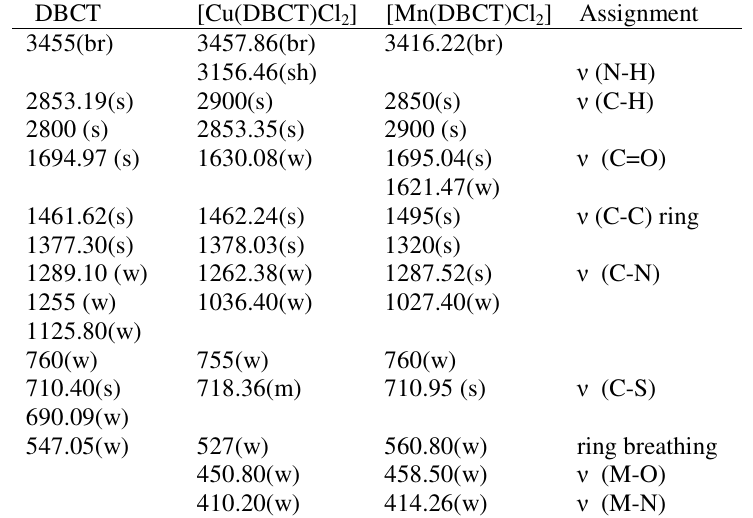
Table 4. IR spectral data (cm -1 ) of DBCT and its Cu(II) and Mn(II) complexes